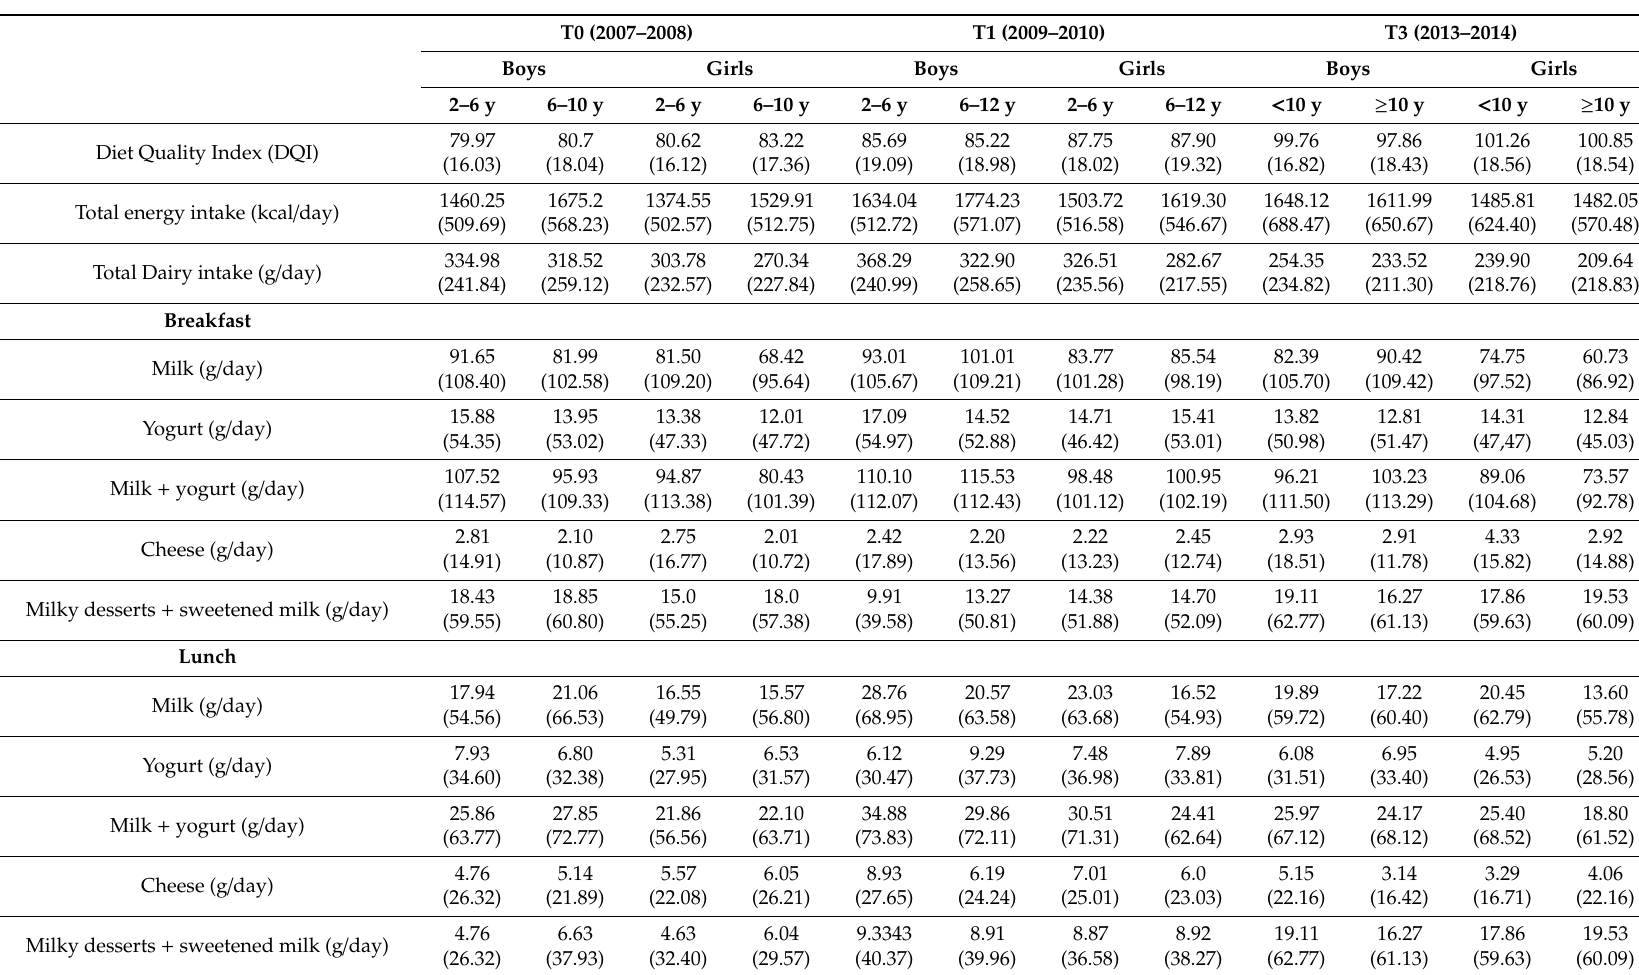
Table 2. Description of dietary information (diet quality, energy, and dairy intakes) at main meals for boys and girls in the di ff erent age categories for each survey